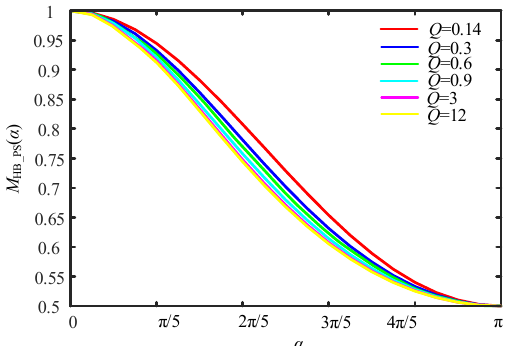
Figure 14. M HB_PS gain curve in half ‐ bridge phase ‐ shift mode.